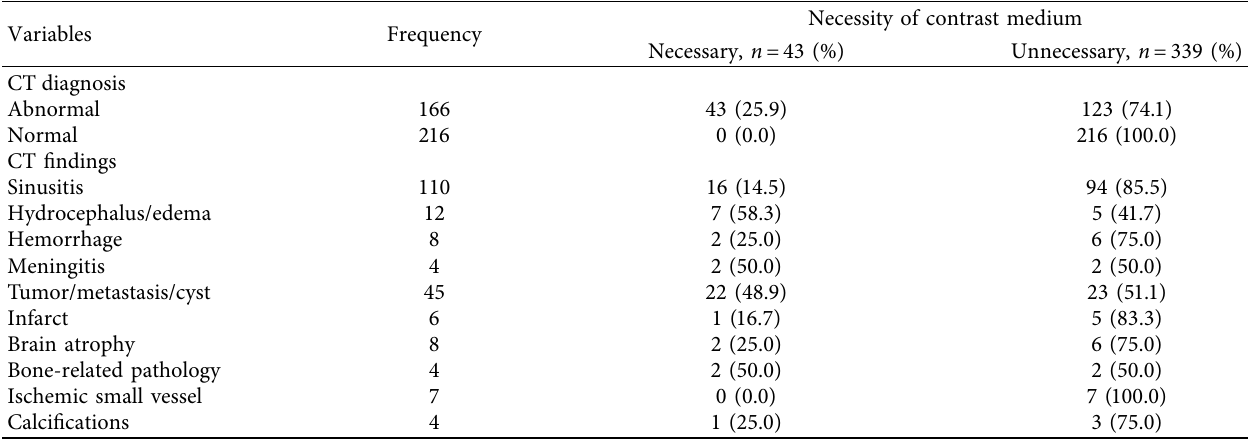
Table 4: Sensitivity analysis of the contrast-enhanced CT group of patients with headache,